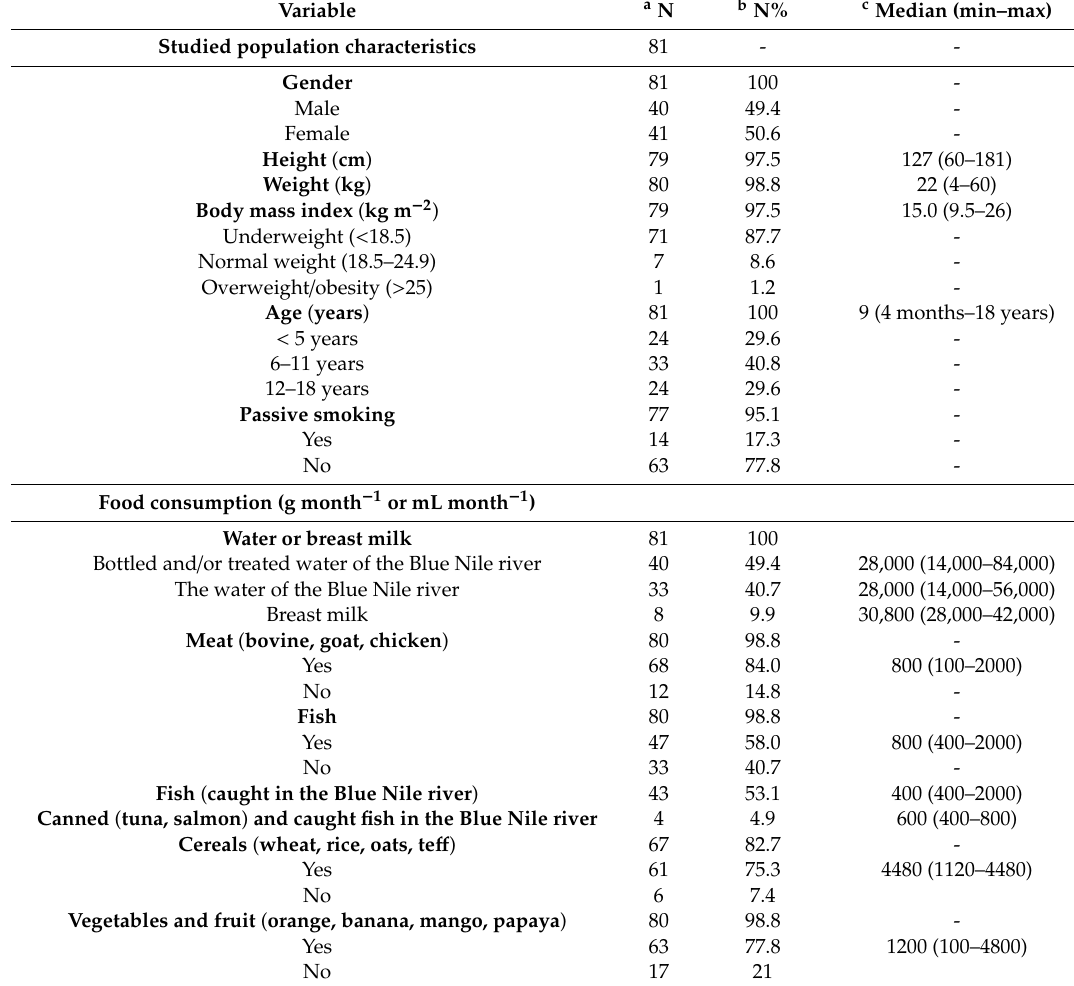
Table 1. Characteristics of the studied population and food consumption.